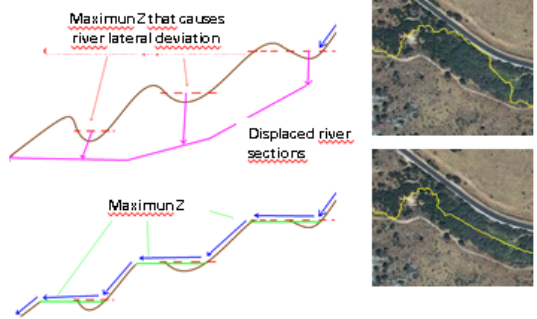
Figure 11. Lift areas correction. Top images shows original situation. Bottom images the result of the correction.